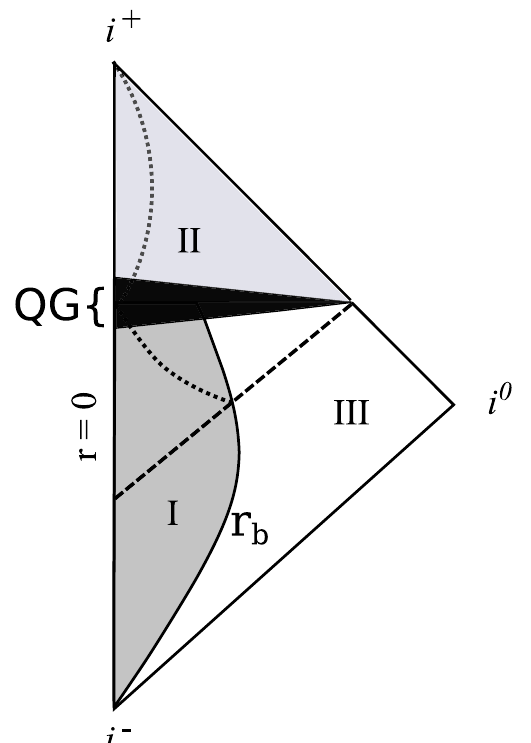
Fig. 5 The Penrose diagram for the model described in case (c) shows threedistinctregionsofspace–timedenotedasI,IIandIII.RegionIrep- resentsthemodifiedOSDcollapse,whichismatchedwithanexpanding FRW universe denoted by region II. The darker triangular region is the quantum gravity dominated region (II.5) under which the collapsing and expanding space–times are joined. The exterior of region I is the vacuum Schwarzschild solution denoted by region III which is matched to interpolating region II.5 inside the horizon at a surface T = T B , the quantum–gravity region II.5 is then matched to the expanding FRW region II at a surface t II = t b . The dotted lines in region I and region II represent the apparent